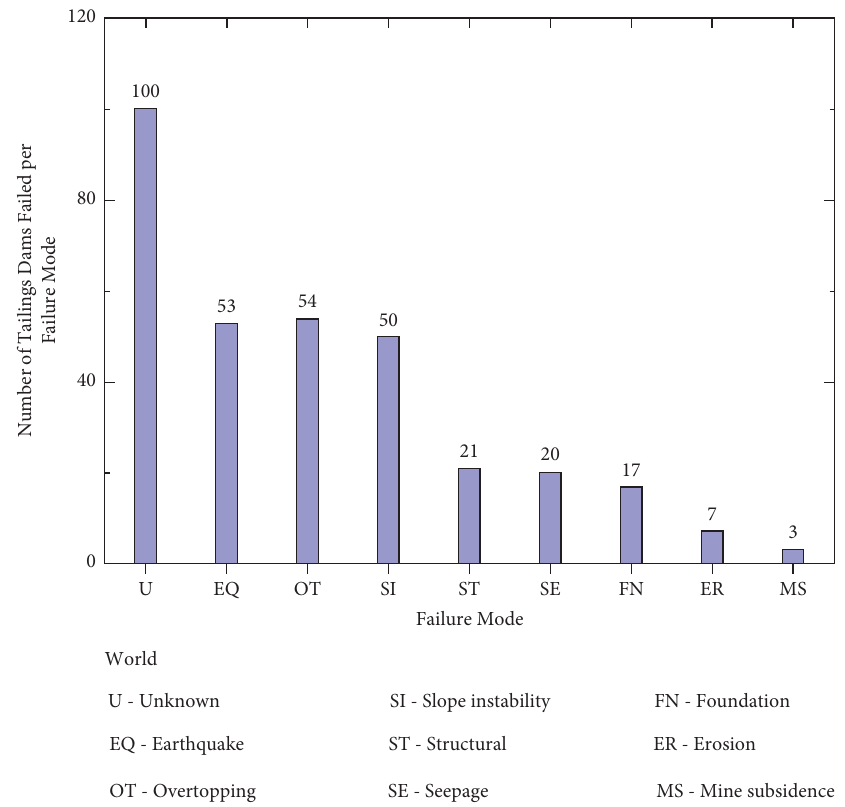
Figure 11: Number of tailings dams failed per failure mode in the world (data from Bowker [22] and Torrez-Cruz